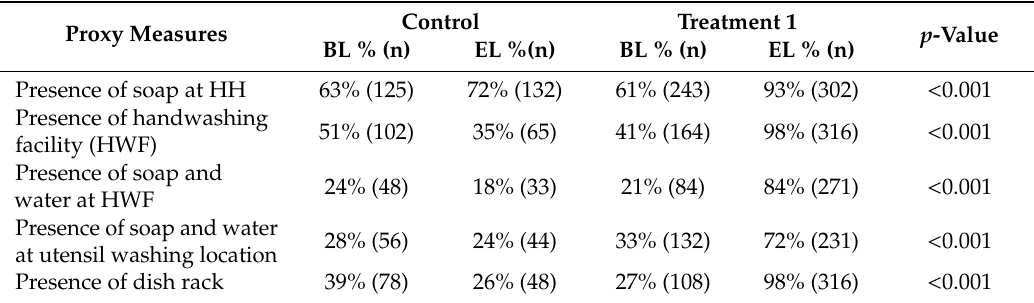
Table 1. Proxy measures compared between Control and Treatment 1 at baseline (2017) and end line